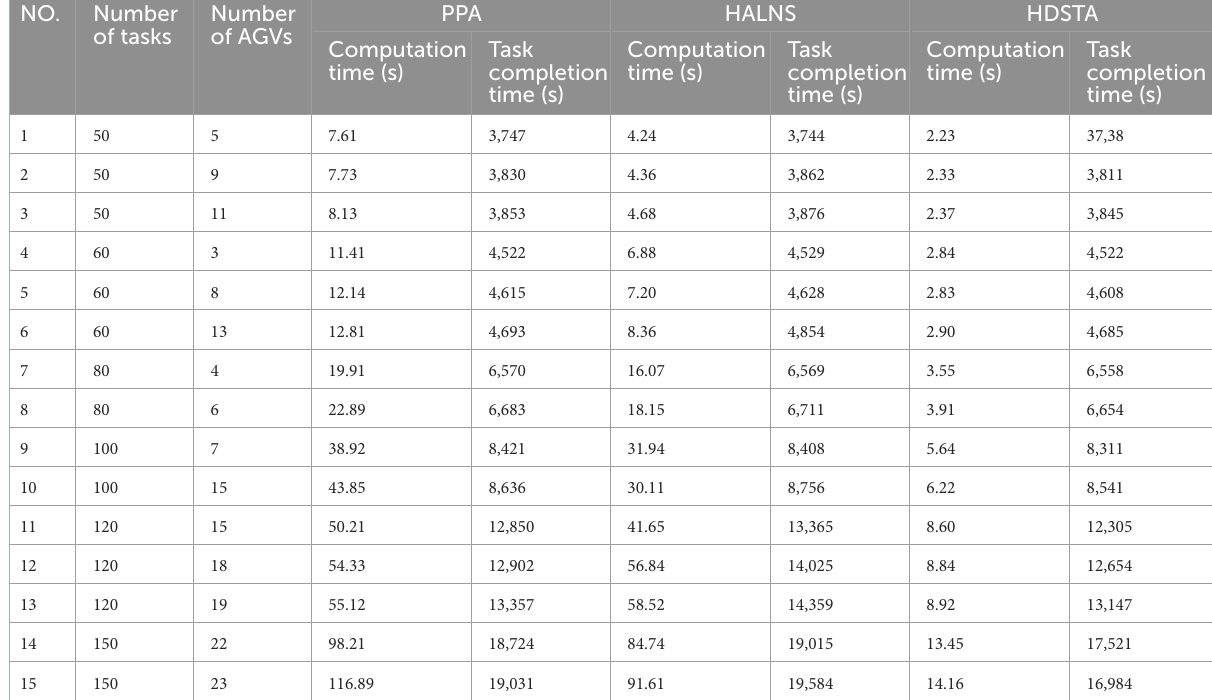
TABLE 2 Results of the varying scenarios.